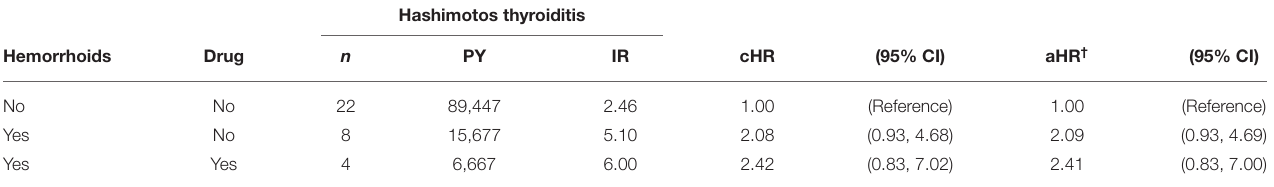
TABLE 3 | Association between hemorrhoid treatment and Hashimoto’s thyroiditis.